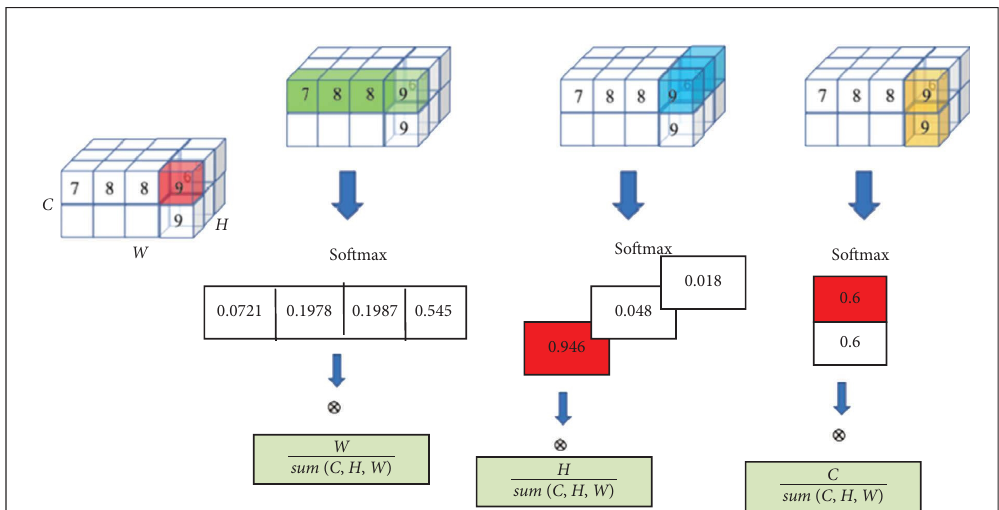
Figure 7: Schematic diagram of multidimensional attention.